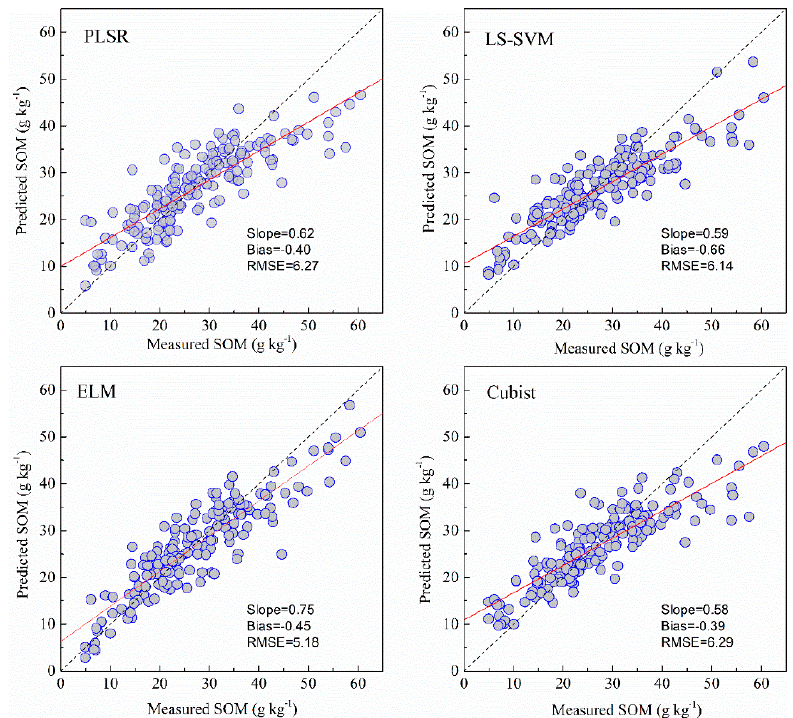
Figure 5. Predicted values plotted against measured values of the validation set for SOM using the PLSR, LS-SVM, ELM and Cubist methods with full bands.